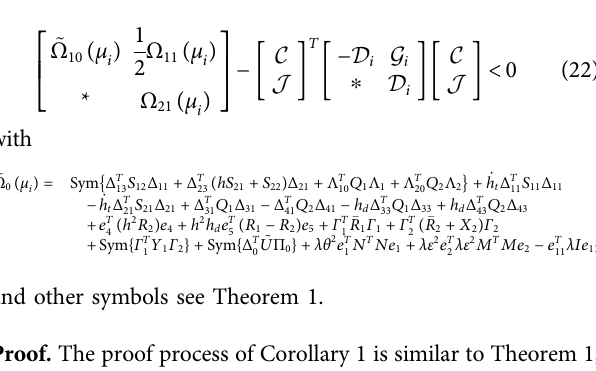
Frontiers in Energy Research |